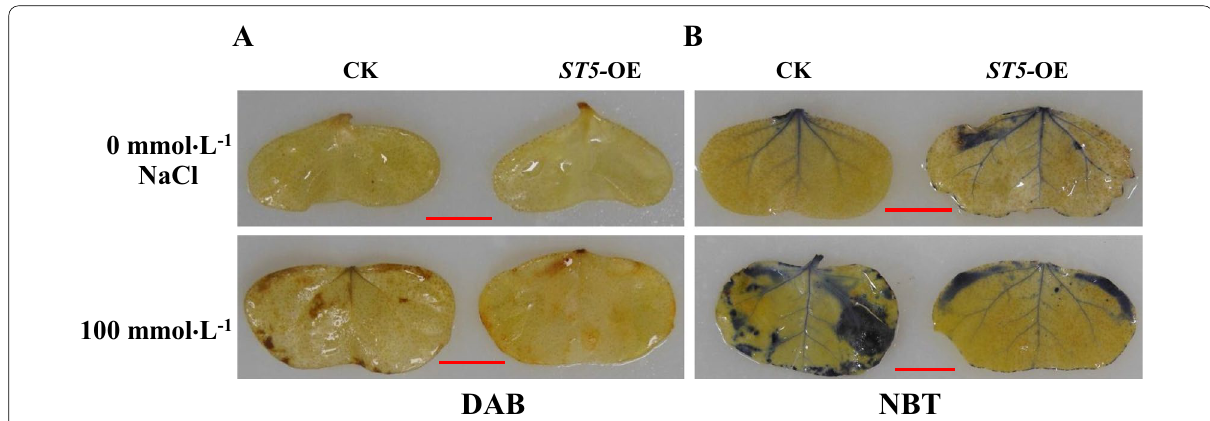
Fig. 4 Overexpression of ThST5 reduced the level of reactive oxygen species (ROS) in cotton. A DAB and B NBT stained leaves of CK and ST5 -OE(11-day old) from 0 mmol L − 1 and 100 mmol L − 1 NaCl treatment Bar 1 cm. A Brown precipitates denotes accumulation of H 2 O 2 . B Blue · · = precipitates represents accumulation of